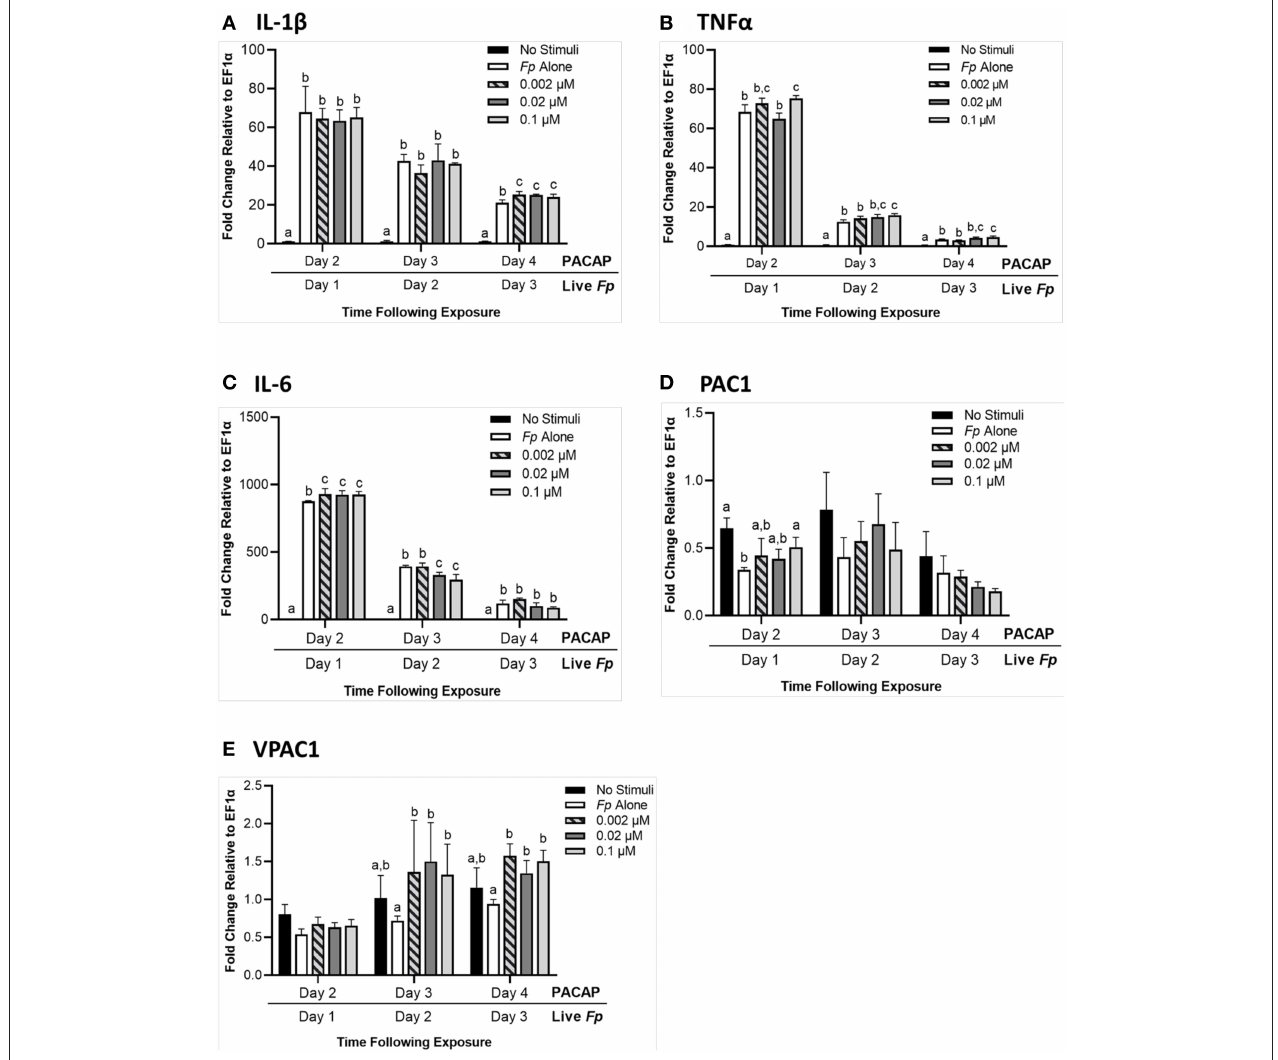
FIGURE 6 | RTS11 transcript expression when challenged with live F. psychrophilum following 24h pre-treatment with PACAP concentrations (0.002, 0.02, and 0.1 µ M). RTS11 that was not exposed to PACAP or live F. psychrophilum was also included as a no stimuli control. To determine whether PACAP has immunomodulatory effects during live infection, transcripts of the pro-inflammatory cytokines IL-1 β (A) , TNF α (B) and IL-6 (C) were measured in RTS11 on days 1, 2, and 3 of infection. The PACAP receptors that are found within RTS11, PAC1 (D) and VPAC1 (E) were also assessed throughout the live infection challenge. All panels represent three independent experiments and are presented as means + SD. A p < 0.05 was considered to be statistically significant when samples were compared within each timepoint. Lowercase letters denote significant differences at p <